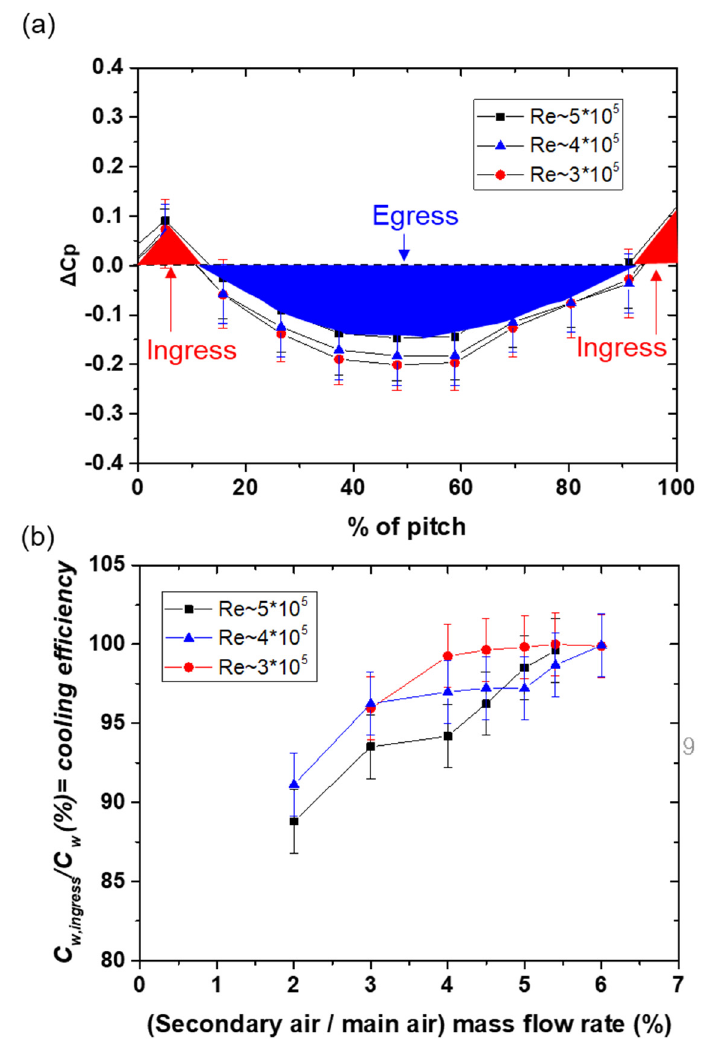
Figure 7. ( a ) Pressure difference between endwall and rim seal; ( b ) Ingress and egress ratio of different coolant mass flow rate and rotational speed .